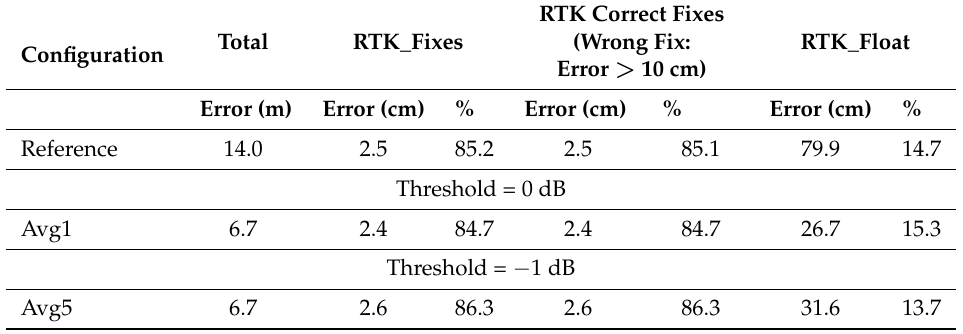
Table 1. Static urban scenario: PVT results for different exclusion thresholds and average